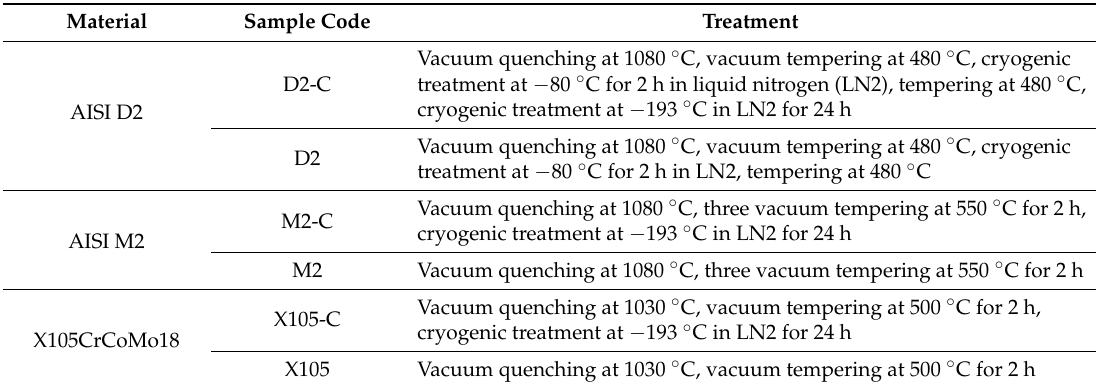
Table 2. List of treatment conditions considered.